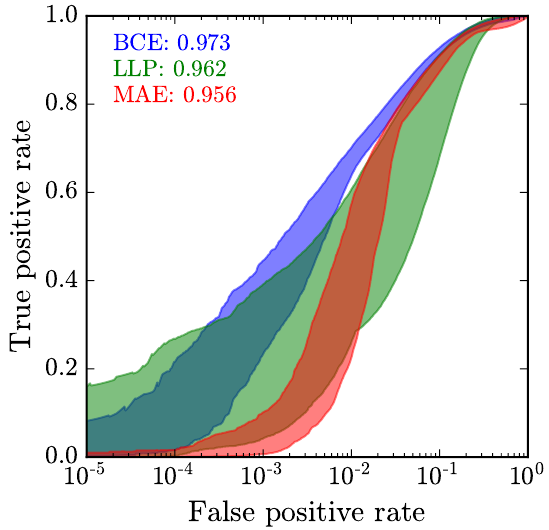
Figure 12 . The spread in the ROC curves for 100 di(cid:11)erent trainings of weak supervision for di(cid:11)erent choices of the loss function. The mean area under the curve is denoted in the legend. The ordering of the legened matches the curves at a false positive rate of 10 (cid:0) 3